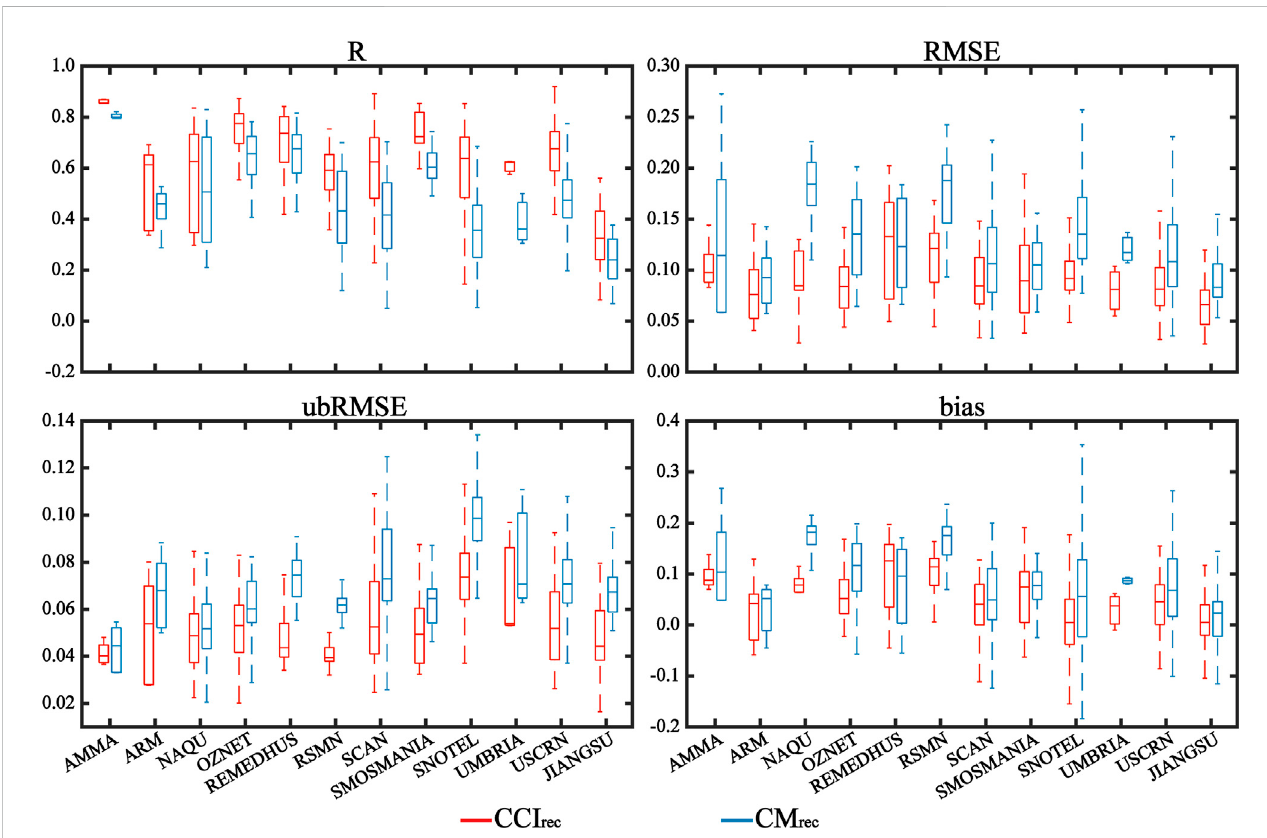
FIGURE 12 Boxplots of R, RMSE, ubRMSE and bias of CCI rec and CM rec evaluated with in-situ observations from twelve soil moisture networks across the globe.